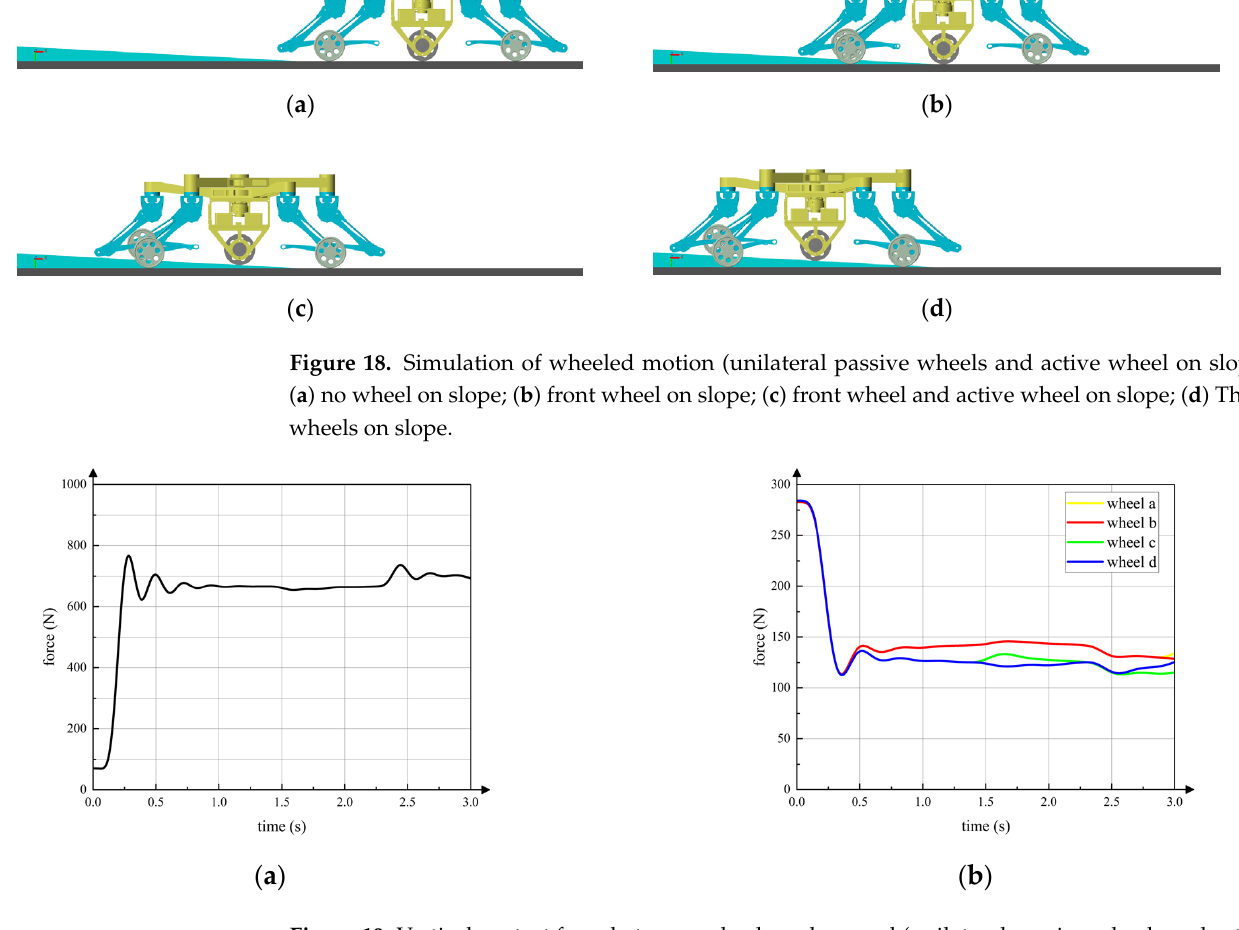
wheel on slope). ( a ) active wheel; ( b ) passive